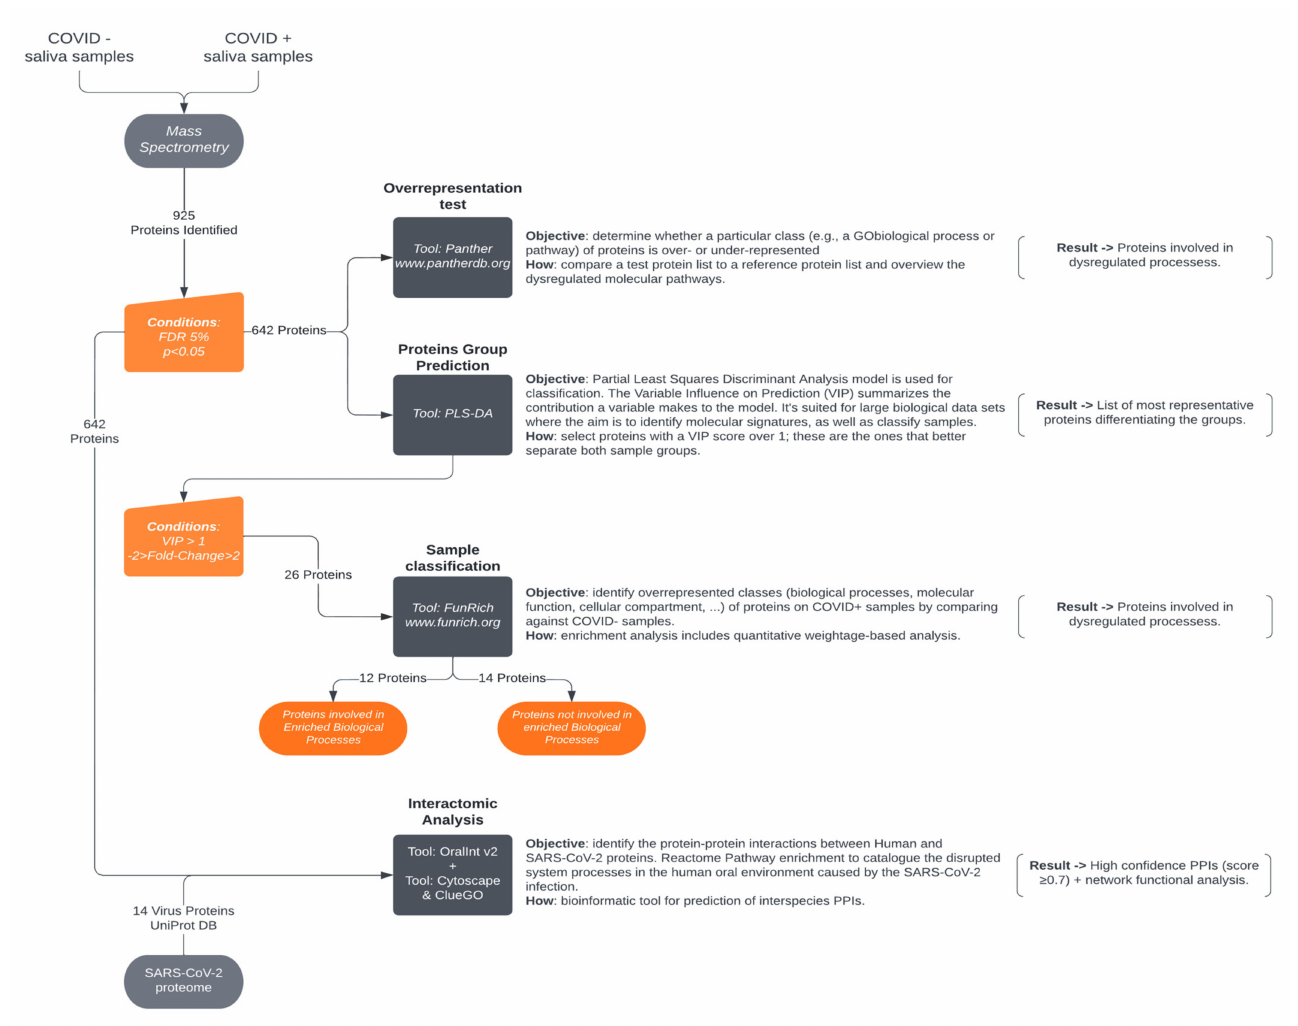
Figure 1. Scheme of the protein functional analysis and interactomics workflow. Proteins were identified by LC-ESI-TOF mass spectrometry. An initial dataset of 925 proteins was narrowed down via filtering by an FDR 5% and p < 0.05 conditions, resulting in 642 salivary proteins then analyzed (GO biological process) by Panther overrepresentation analysis. Proteins (26) with a VIP > 1 (PLS-DA model) and − 2 > Fold-Change > 2 defined were used in sample classification analysis with the FunRich tool. The enrichment resulted in 12 proteins with dysregulated processes and with p < 0.05. Interactome analysis on the narrowed down dataset against the SARS-CoV-2